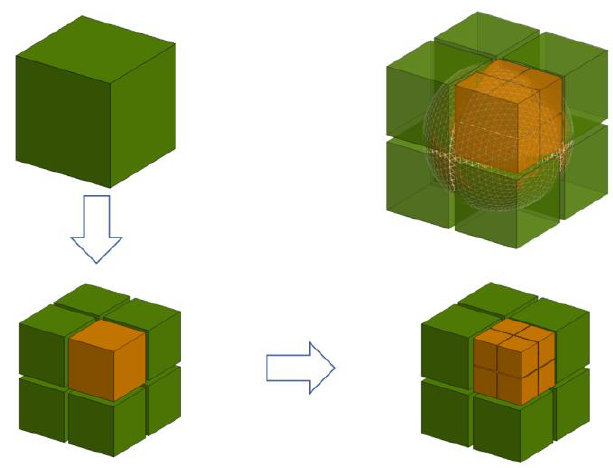
Figure 3. Schematic diagram of octree structure.